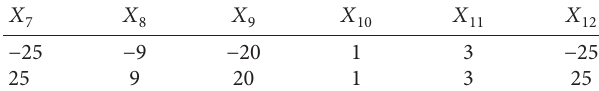
Table 13: : Model-free checks with edge plan in Table 12.